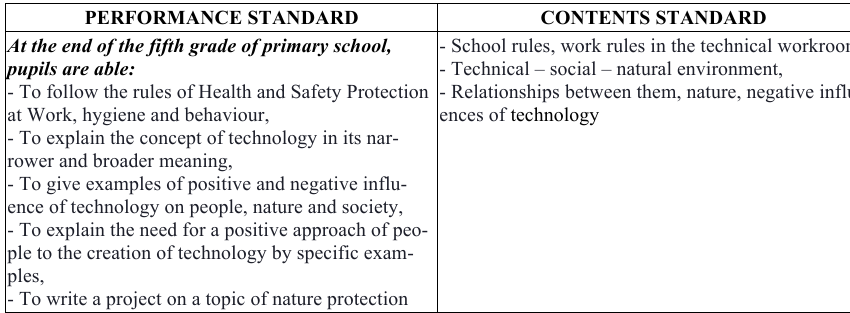
Table 2. Requirements for the performance and contents standard of pupils at the end of the fifth grade of primary school (thematic field Technology, thematic unit People